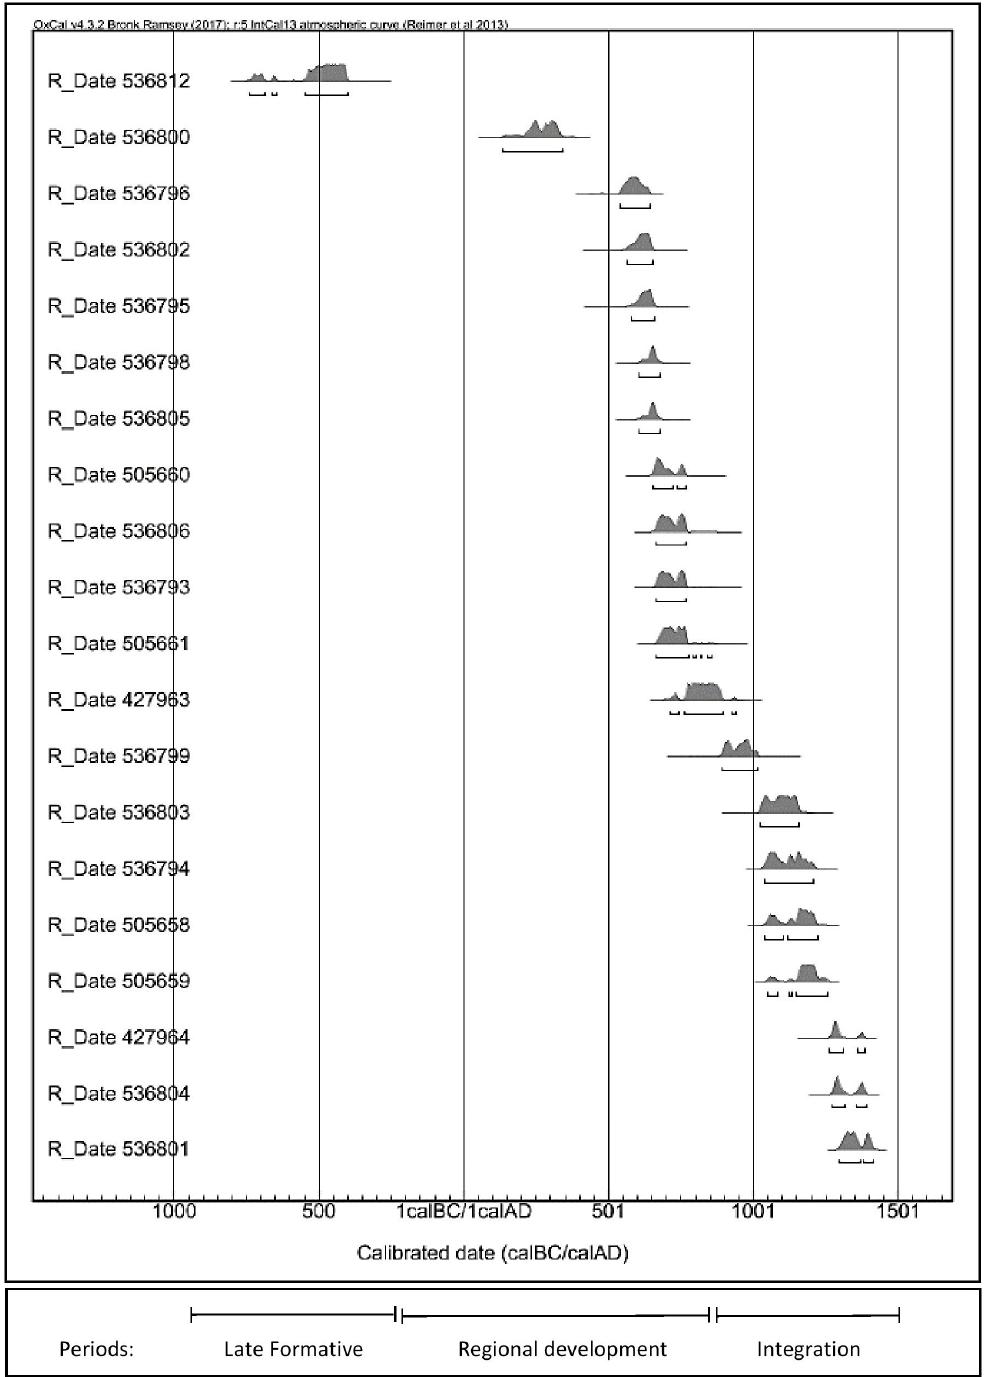
Figure 5. The probability graph of the radiocarbon dating calibrated to 2 σ , corresponding to the agriculturization processes of the archeological landscape of the Chanchán basin.